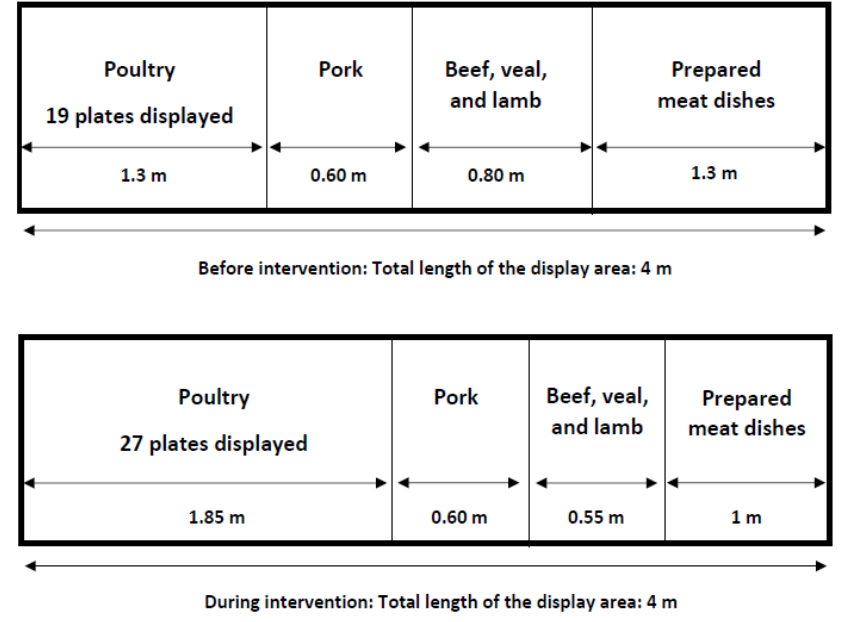
Figure 1. Schematic overview of the display area in the butchery before and during the intervention.